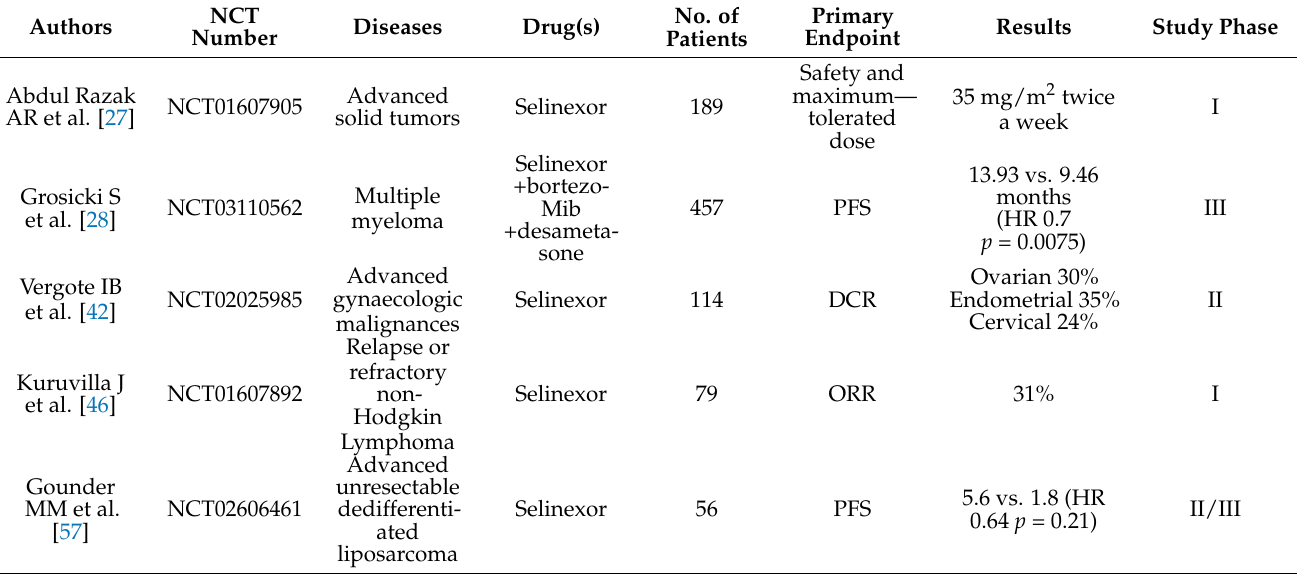
Table 1. Summary of clinical studies with